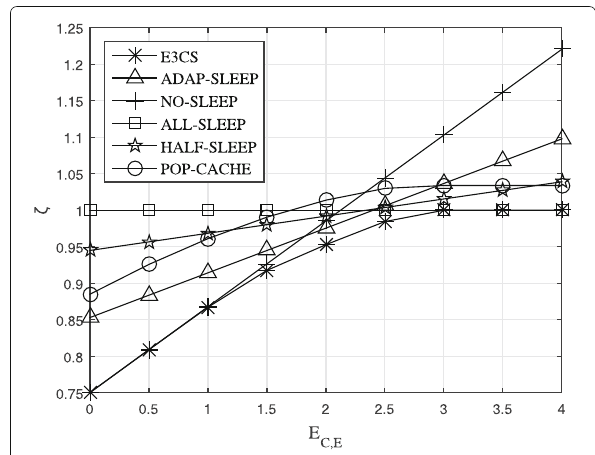
Fig. 5 Effect of the energy consumption E C , E to deliver contents from the network edge